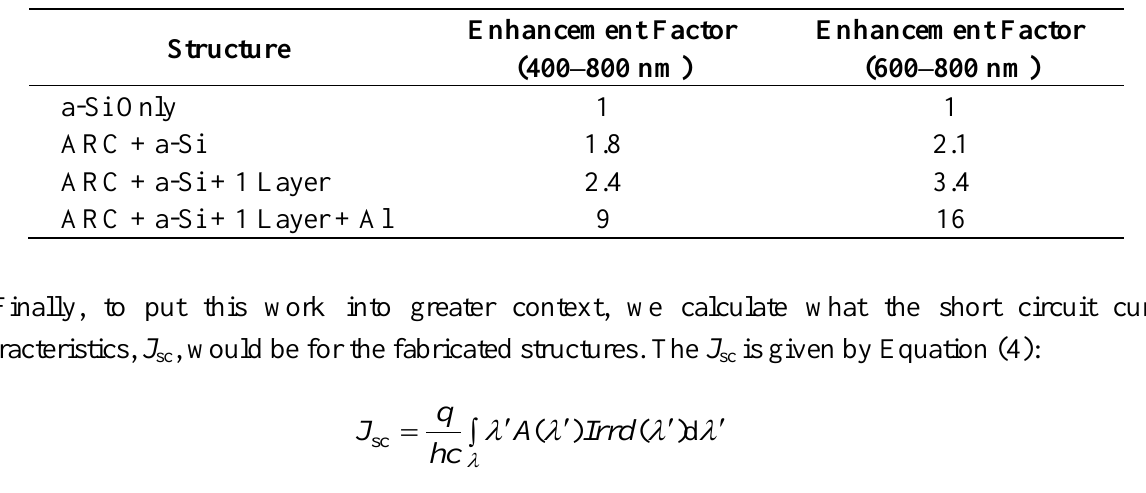
Table 5. Enhancement factor of the different design structures considered in this